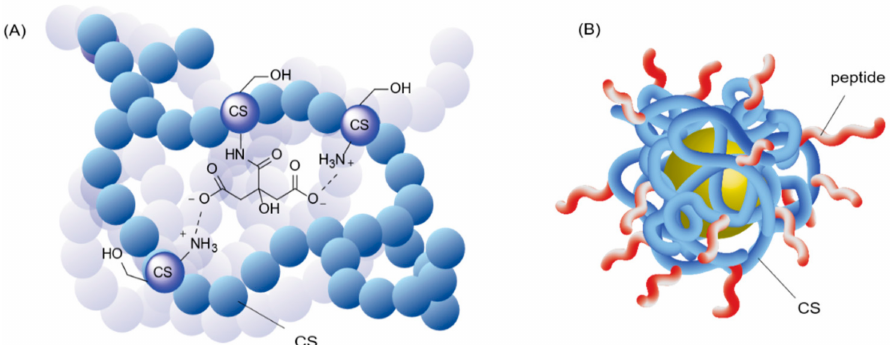
Figure 9. Illustrations of the difference between bulk and surface functionalization of CS hydrogels. ( A ) Interaction between citric acid (CA) and CS in bulk. Inspired from [149]. For visibility, the CS units not involved in the interaction are represented by a simple blue ball. CA is both covalently linked to a CS unit and engaged in ionic interactions with the surrounding glucosamine. ( B ) External peptide functionalization of a core-shell system of CS-Au NP. The peptides are covalently linked to the outer CS shell coating. In this case, the peptides are all oriented towards the outside of the complex. Inspired from